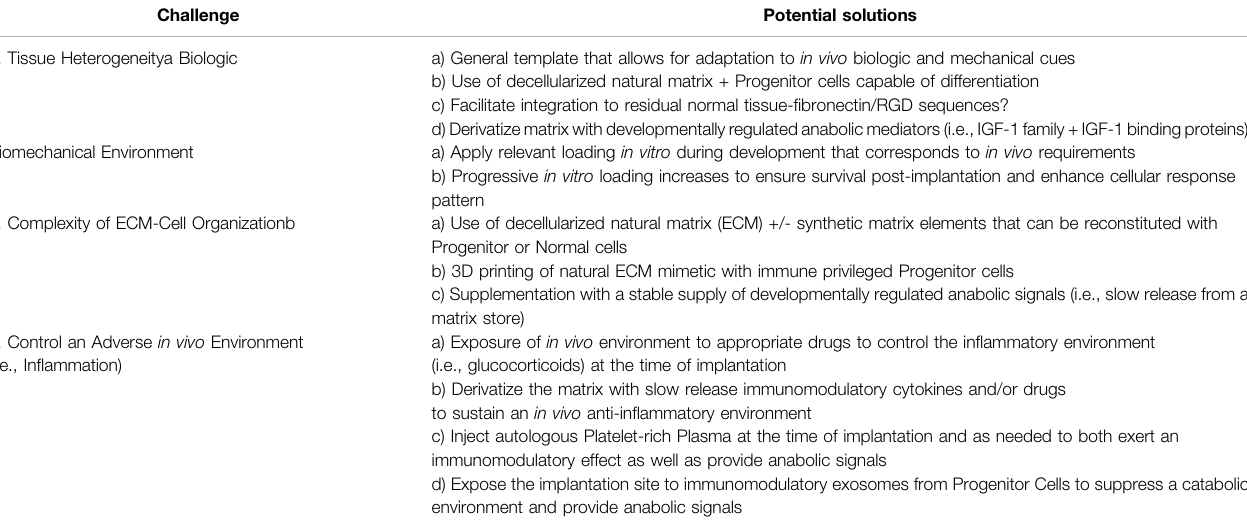
TABLE 1 | Challenges for tissue engineering success for repair/regeneration of musculoskeletal tissues.